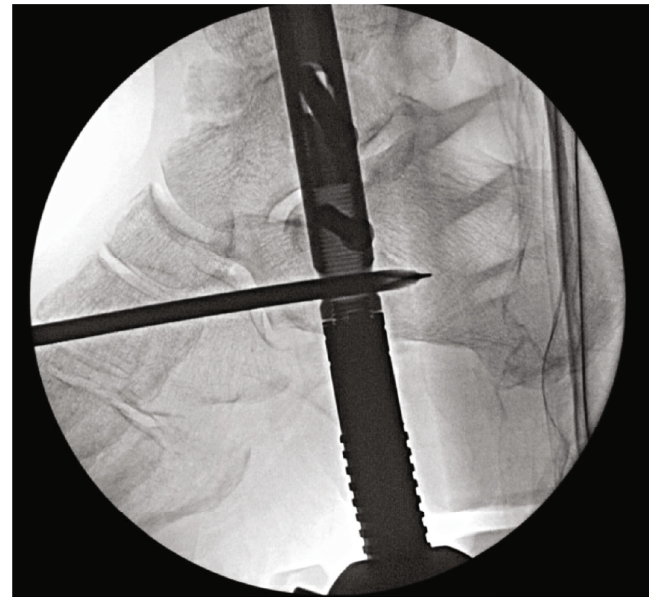
Figure 5: Technique for placement of calcaneal interlocking screw in the tibiotalocalcaneal